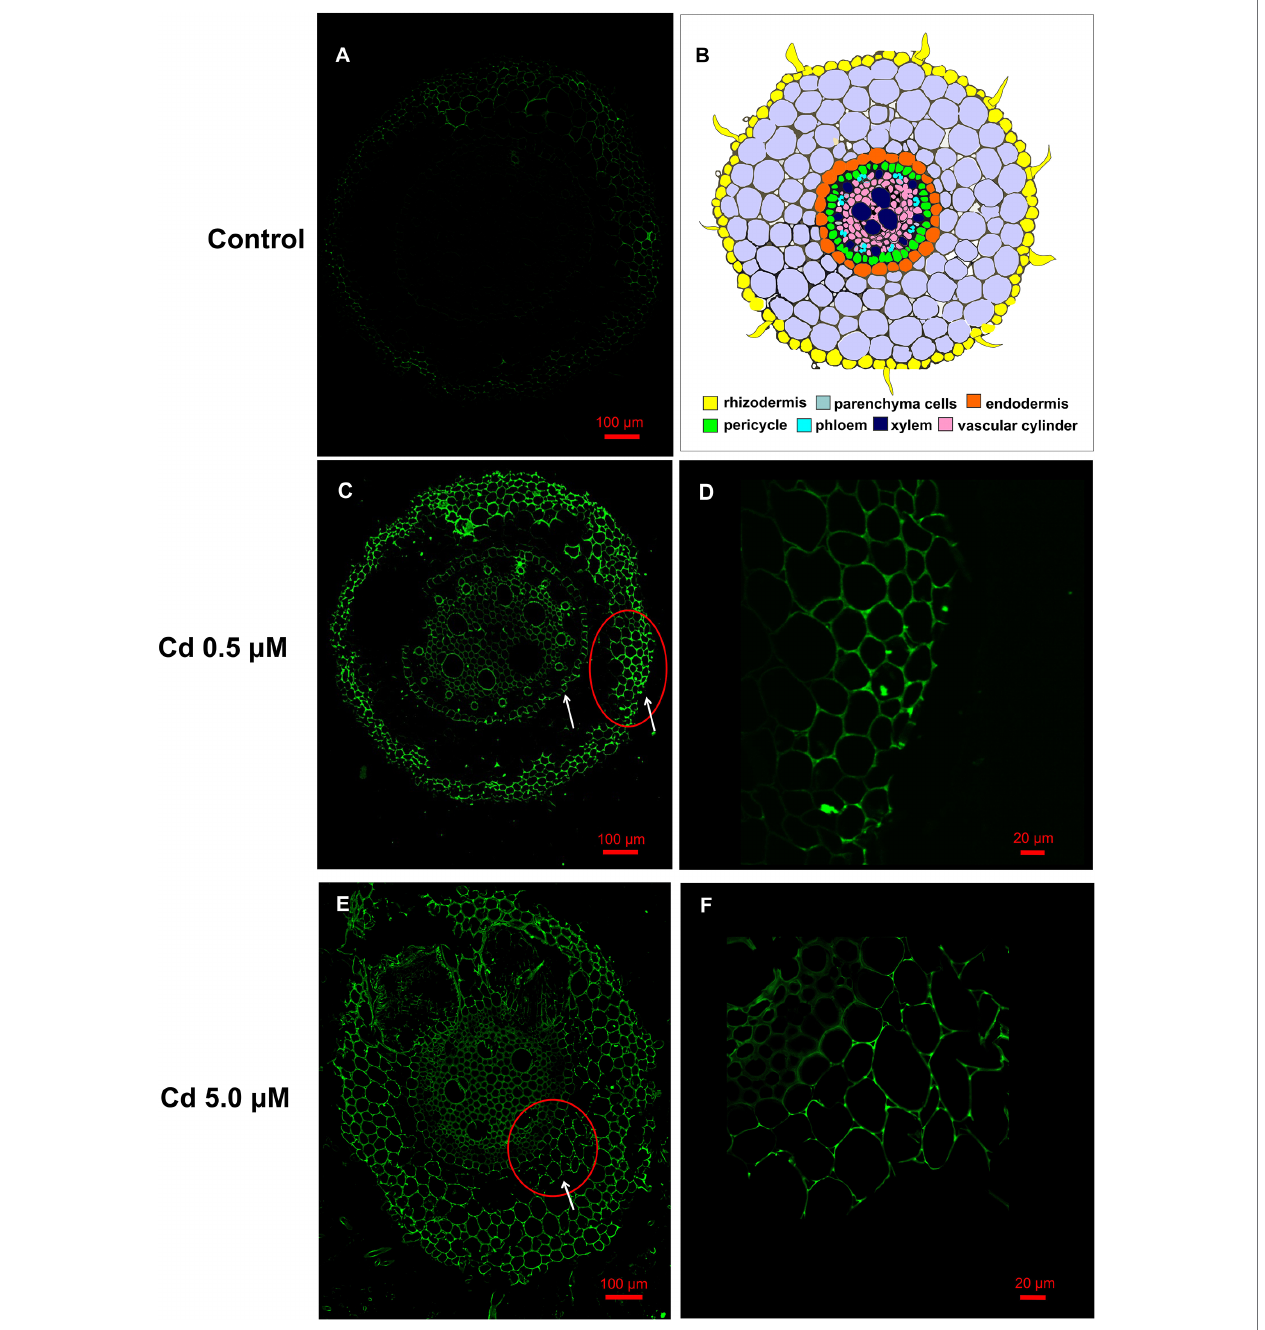
FIGURE 5 | Cd accumulation in roots of the wheat (15 days from sprouting and from the start of Cd treatments) visualized by fluorescent imaging using Leadmium Green AM dye. Green fluorescence represents the binding of the dye to Cd. Panel (A) Control roots, a faint but not bright signal is present. Panel (B) Schematic overview of wheat root anatomy. Panel (C) Roots grown in presence of Cd 0.5 μ M, fluorescence is localized in rhizodermis and endodermis (white arrows). Panel (D) Detail at higher magnification of the rhizodermis area corresponding to red circle of panel C . Panel (E) Roots grown in presence of Cd 5.0 μ M, fluorescence is also distributed in the cell wall of the parenchyma cells of the cortical region (white arrows). Panel (F) Detail at higher magnification of the corresponding to the red circle of panel E